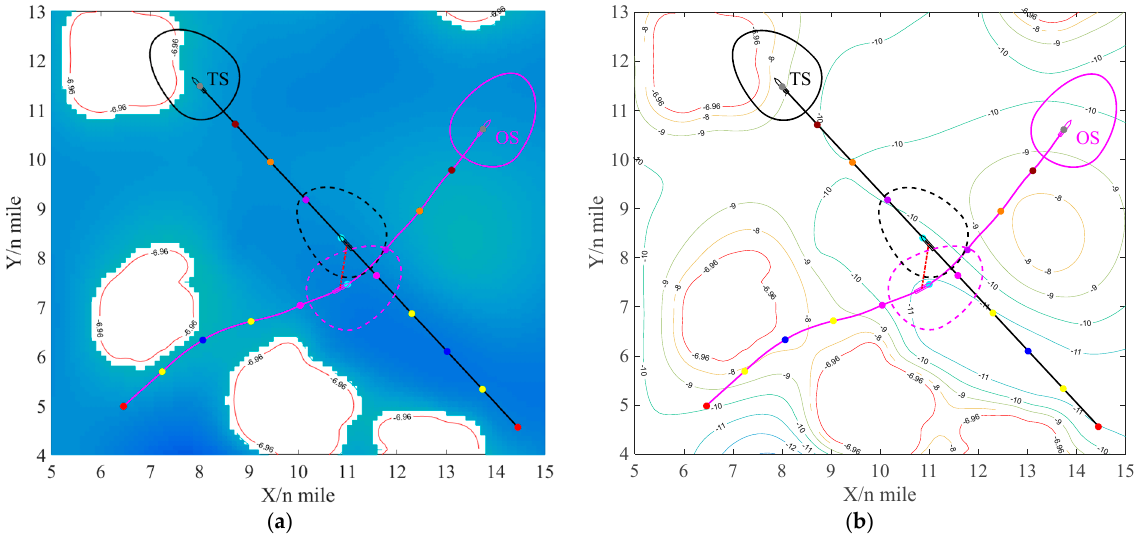
Figure 15. Ship local path planning results in crossing situation. ( a ) Navigable map ( b ) Depth con- tour.